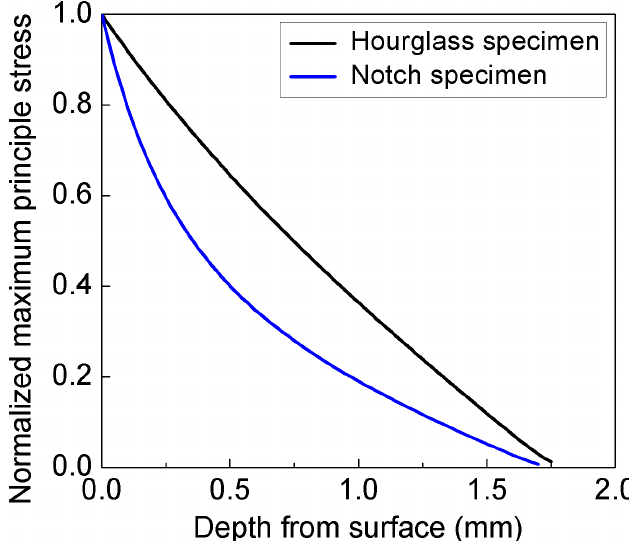
Figure 1. Shape and dimension (in mm) of fatigue specimens. ( a ) Hourglass specimen with K t = 1.07; ( b ) Notch specimen with K t = 1.43.